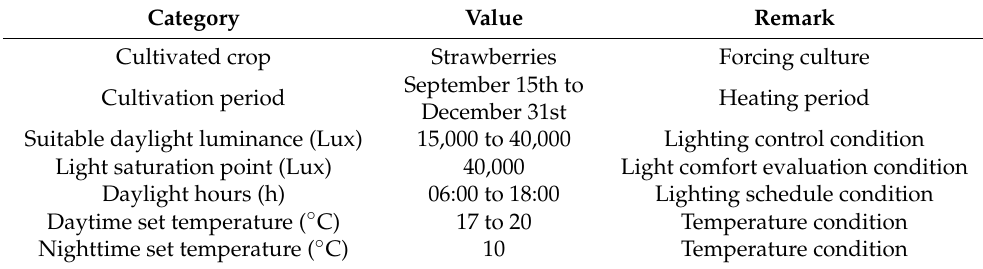
Table 1. Strawberry cultivation conditions.